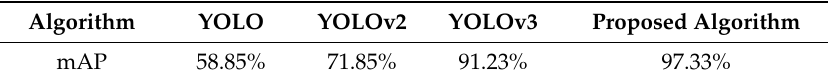
Table 3. Mean Average Precision